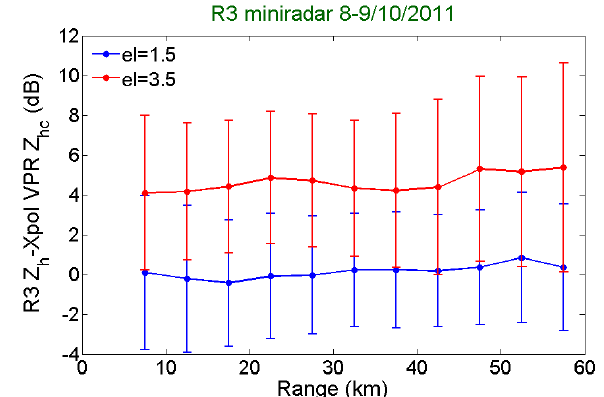
3 Figure 9. Statistical difference between R3 mini-radar and XPol measurements versus range during the 8-9/10/2011 rain event for two different antenna elevation angles. 4